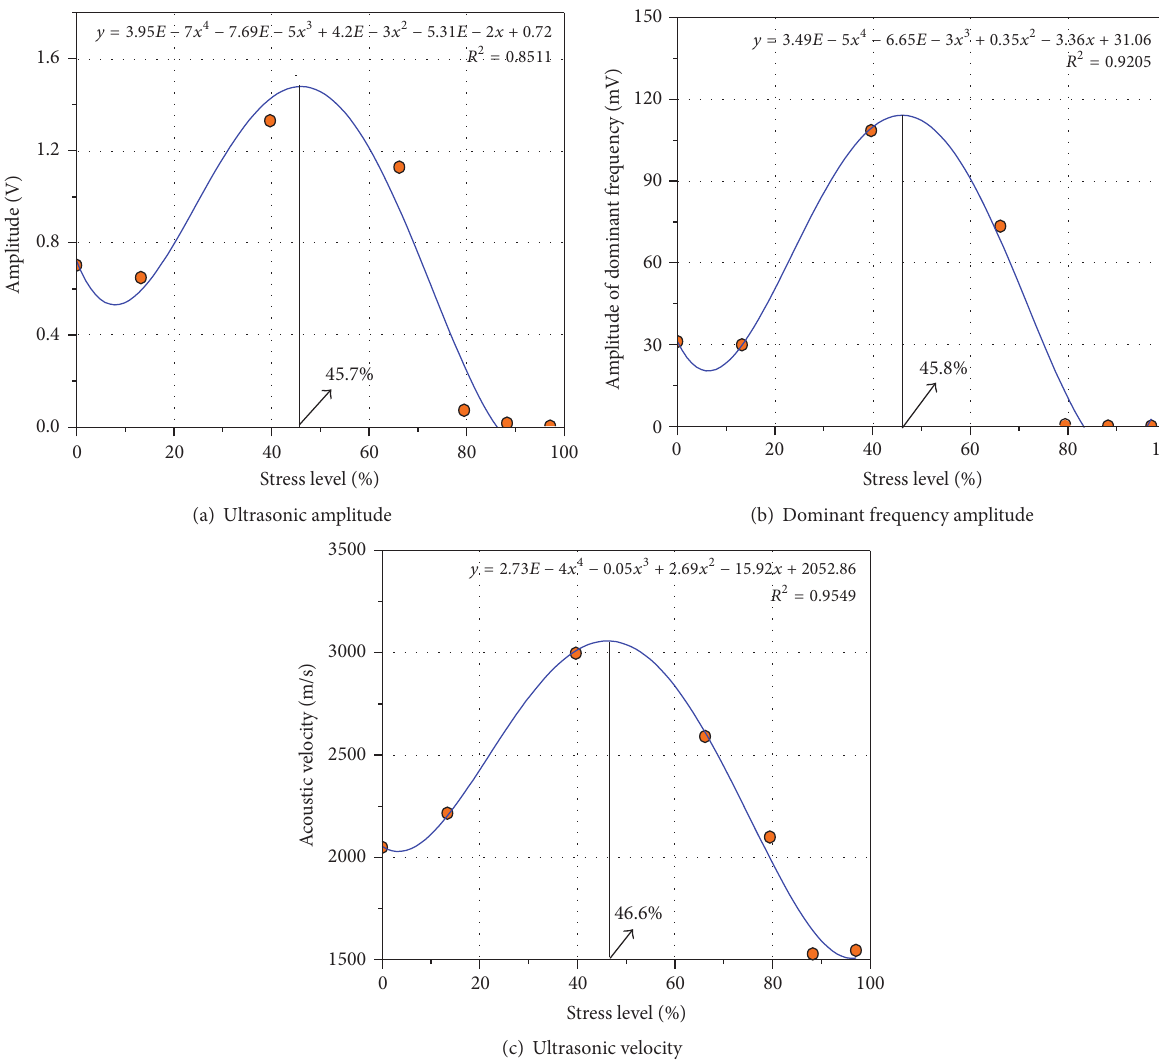
Figure 8: The result of regression equation of ultrasonic